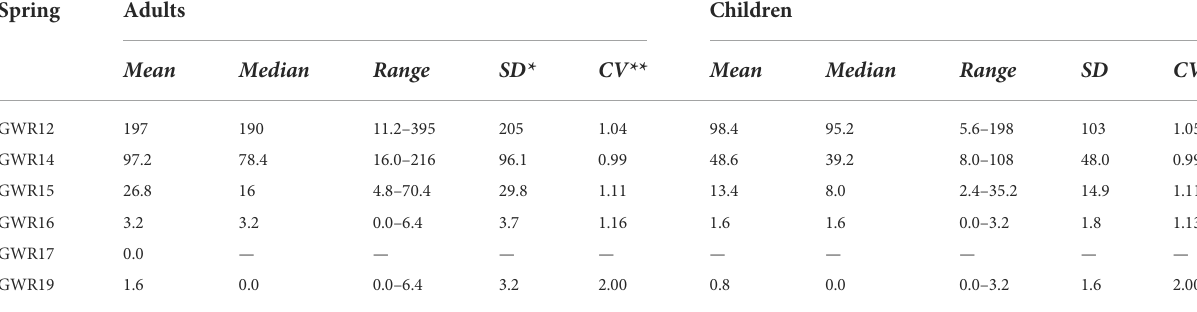
TABLE 3 The ingested dose of E. coli (ingested volume of water × mean concentration of E. coli expressed in CFU/100 ml) in relation with the water consumption by adults (2 L/person/day) and children (1 L/person/day). Spring Adults